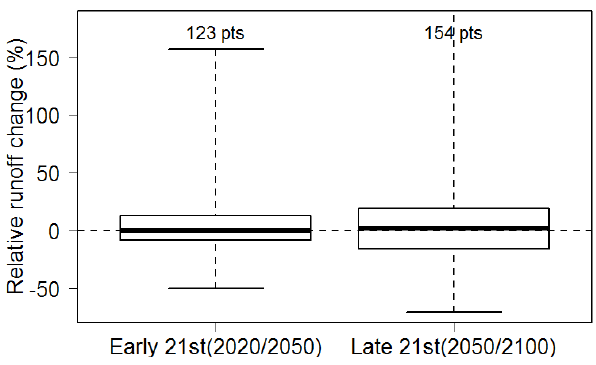
Figure 3. Impact of climate change on runoff at the beginning of the 21st century (left, 2020–2050) and at the end (right, 2050–2100).